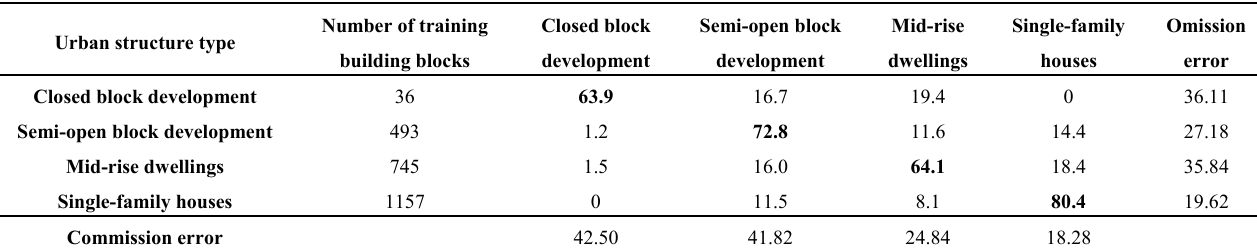
Table 3. Error matrix of the urban structure type classification. Ground truth data in rows, classification result in